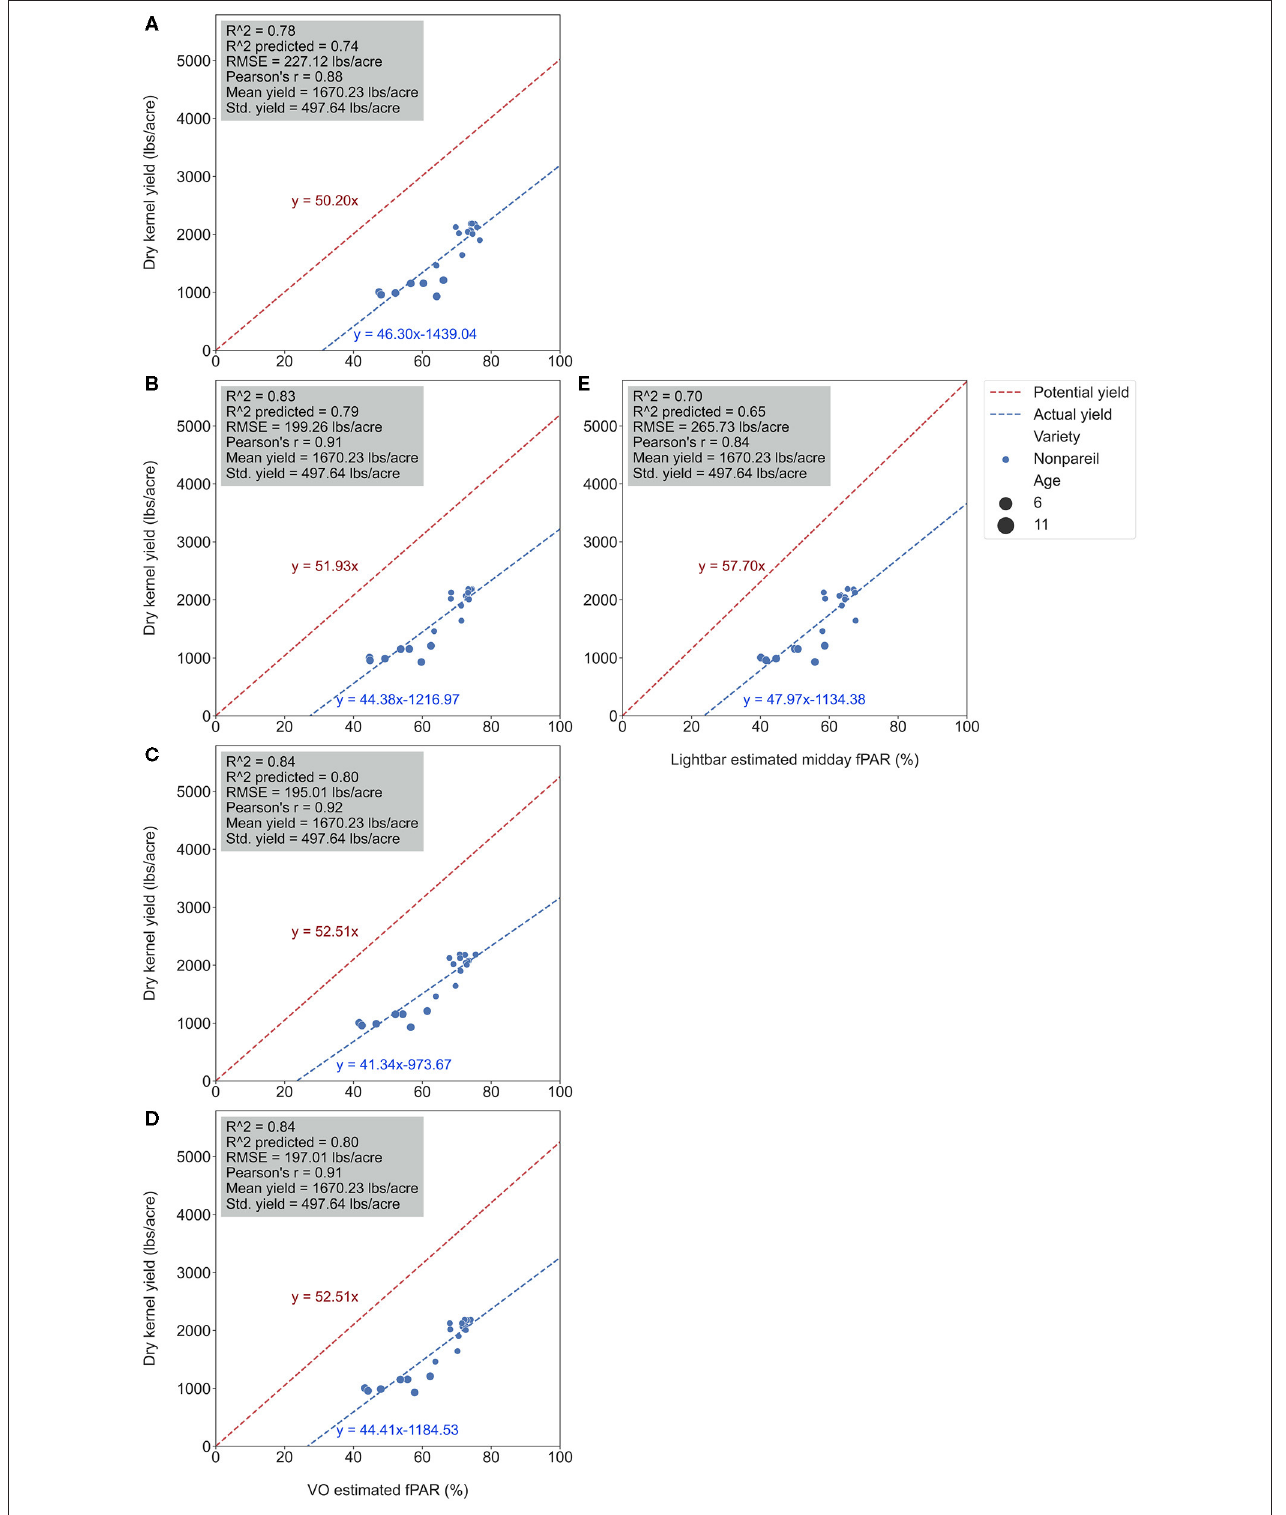
FIGURE 8 | Comparison of accuracies of actual ‘Nonpareil’ almond yield explained by Virtual Orchard (VO) estimated canopy Fractional PAR (fPAR) over the season: May 28 (A) , June 26 (B) , July 26 (C) , August 7 (D) , and the mobile lightbar platform (June 26) (E) at the per-row level in 2019. The potential almond yield (57.7 lb acre − 1 ) was based on the results reported by Jin et al. (2020) using a lightbar.